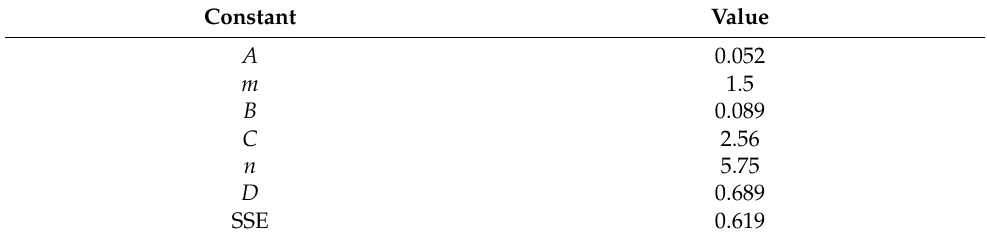
Figure 15. Corrected flame widths for the two-pad experiments. Lines are best overall fit correlations using Equation (12). Average error bars (95% confidence intervals) are only shown on the S y = 0 data for convenience. Table 7. Curve-fit constants for correlation of two-pad flame width data (Equation (12)).